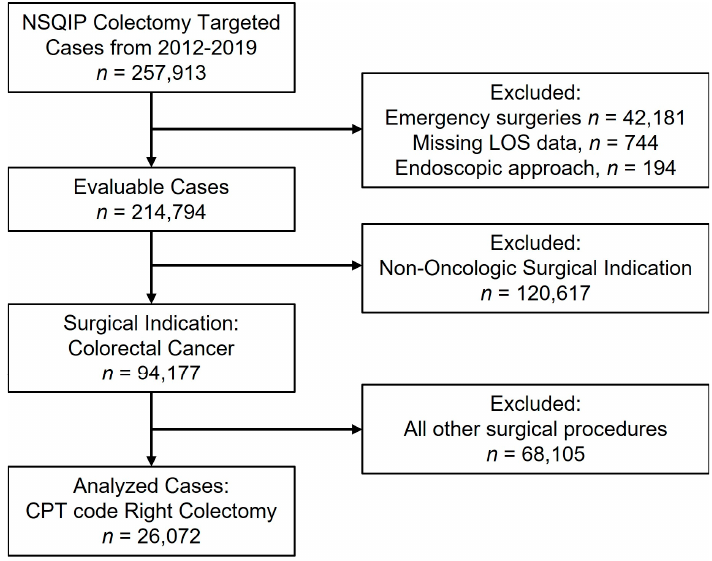
Figure 1. Consort diagram. LOS, length of stay; CPT, current procedural terminology.